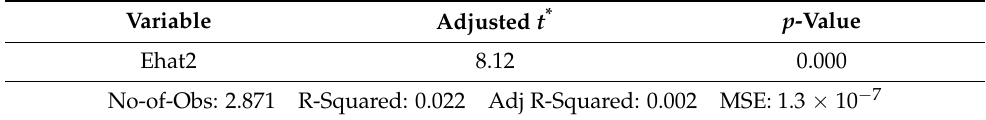
Table 5. Regression results (squared residuals).